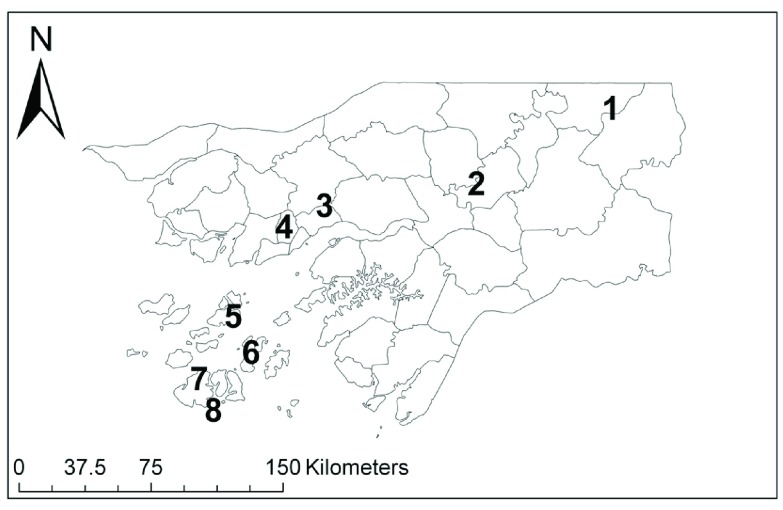
Collection sites in Guinea-Bissau.1: Canjufa (12.43N, 14.13W), 2: Bambadinca (12.02N, 14.86W), 3: Antula (11.91N, 15.58W), 4: Prabis (11.80N, 15.74W), 5: Abu (11.46N, 15.91W), 6: Brus (11.23N, 15.88W), 7: Ponta Anabaca (11.18N, 16.14W) and 8: Eticoga (11.16N, 16.14W).